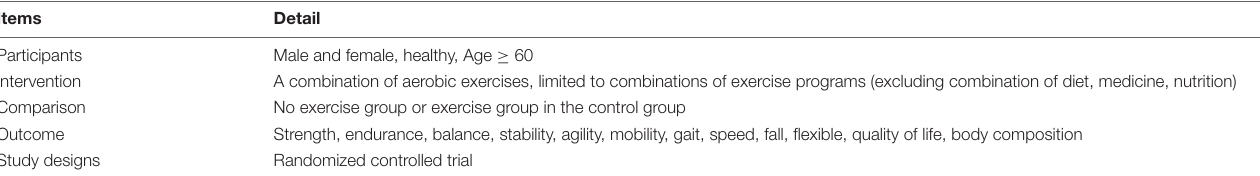
TABLE 1 | Inclusion